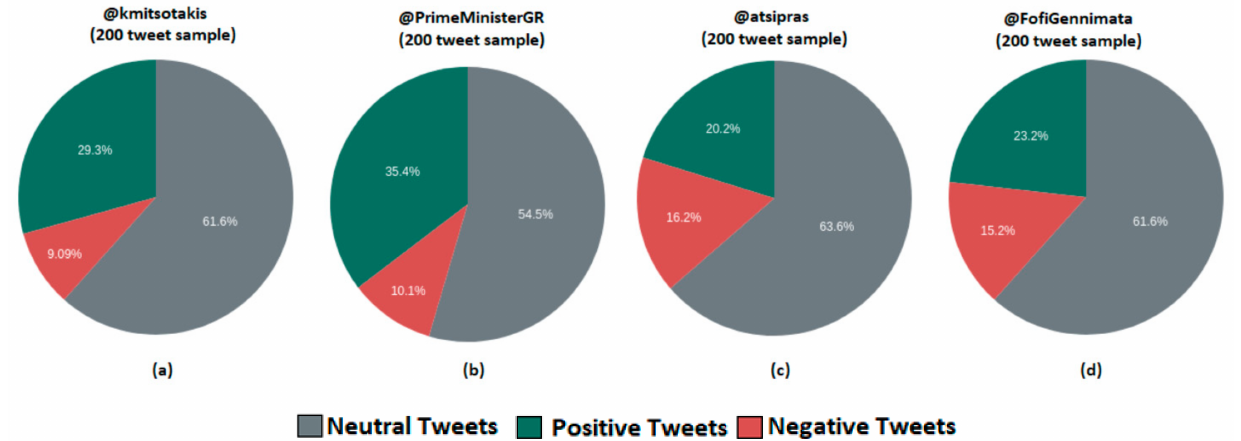
Figure 25. Sentiment analysis of tweets mined from @kmitsotakis, @primeministerGR, @atsipras, and @FofiGennimata accounts (800 tweet sample; 200 tweets per account).